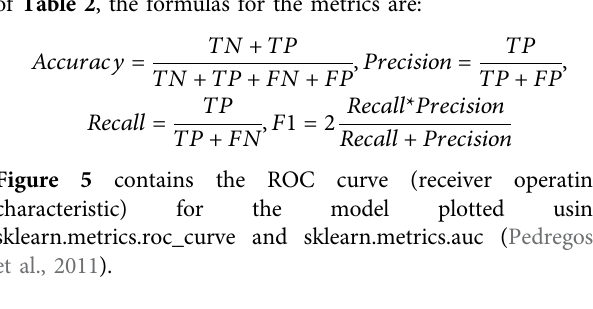
Frontiers in Physiology |